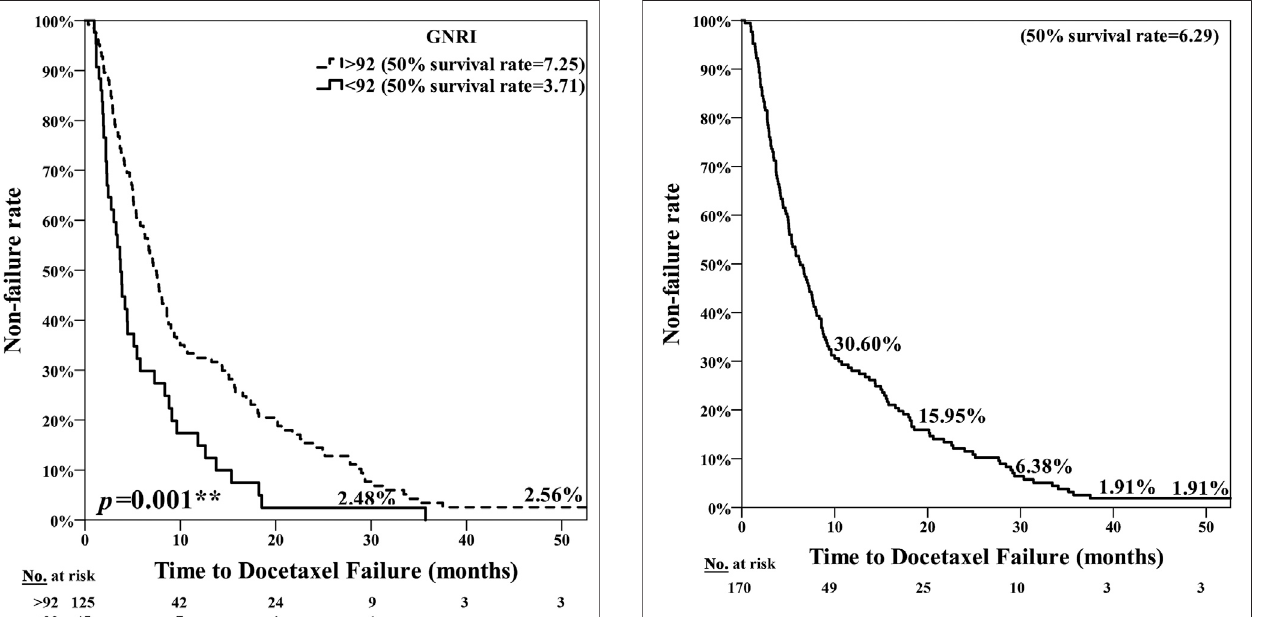
FIGURE 3 | PSA Progression Free Survival (PFS) for mCRPC patients treated with docetaxel for a median of 6.29 months.